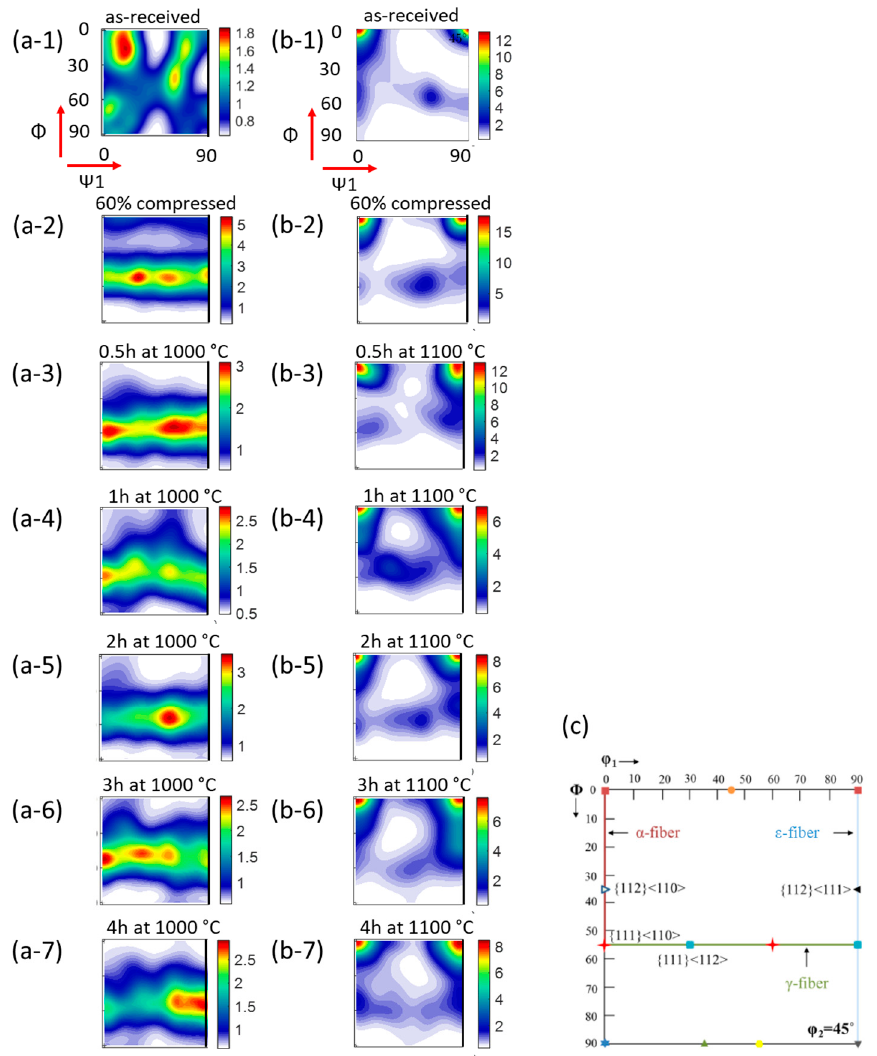
Figure 3. ODF sections of Ψ 2 = 45° for ( a ) 60% compressed and 1000 °C annealed FeCrAl samples, ( b ) 60% compressed and 1100 °C annealed 14YWT samples, ( c ) Schematic illustration of the important texture components in bcc materials [24].